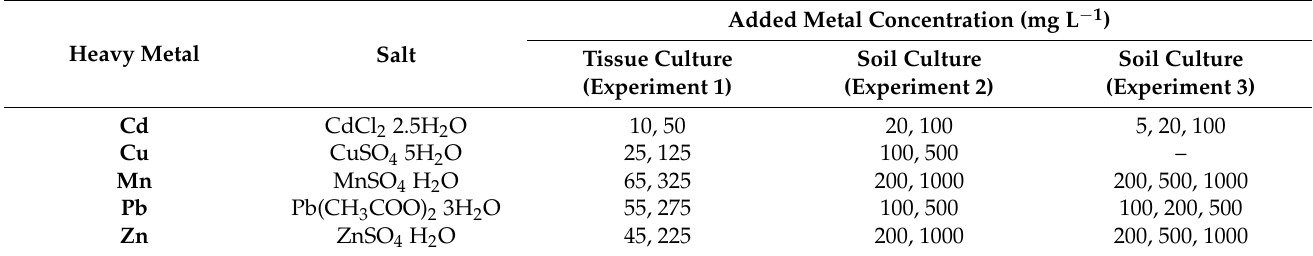
Table 2. Heavy metal salts and metal concentrations in culture medium or soil used in the present study.